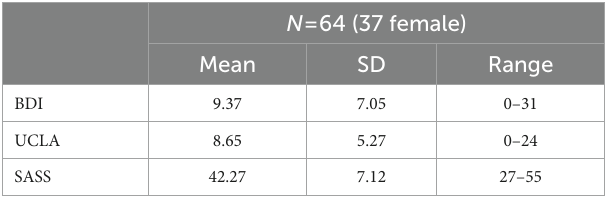
TABLE 3 Sample performance in self-report scales for Sample